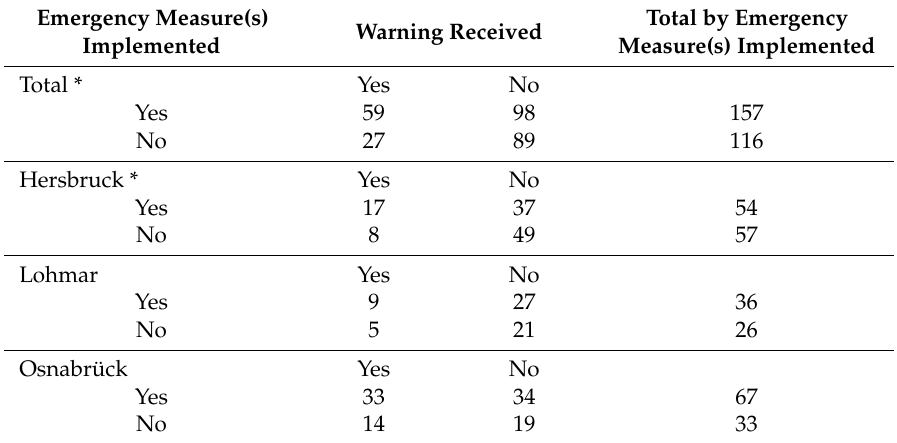
Table 4. Contingency table showing the number of respondents by implemented emergency measures and received warning (EM: emergency measure).